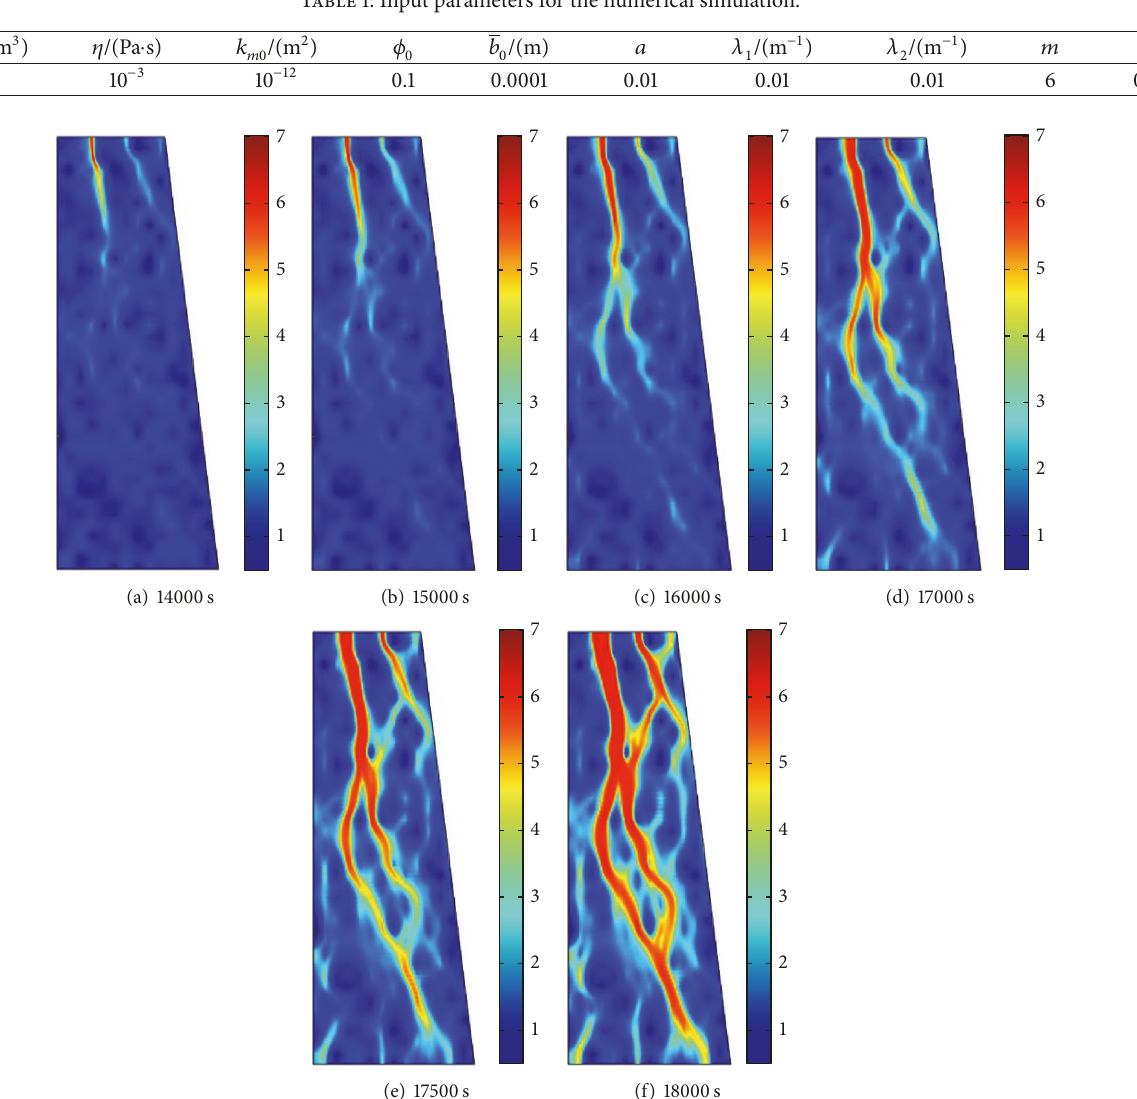
Figure 14: The spatial distribution of aperture 𝑏 (10 −4 m ) at different